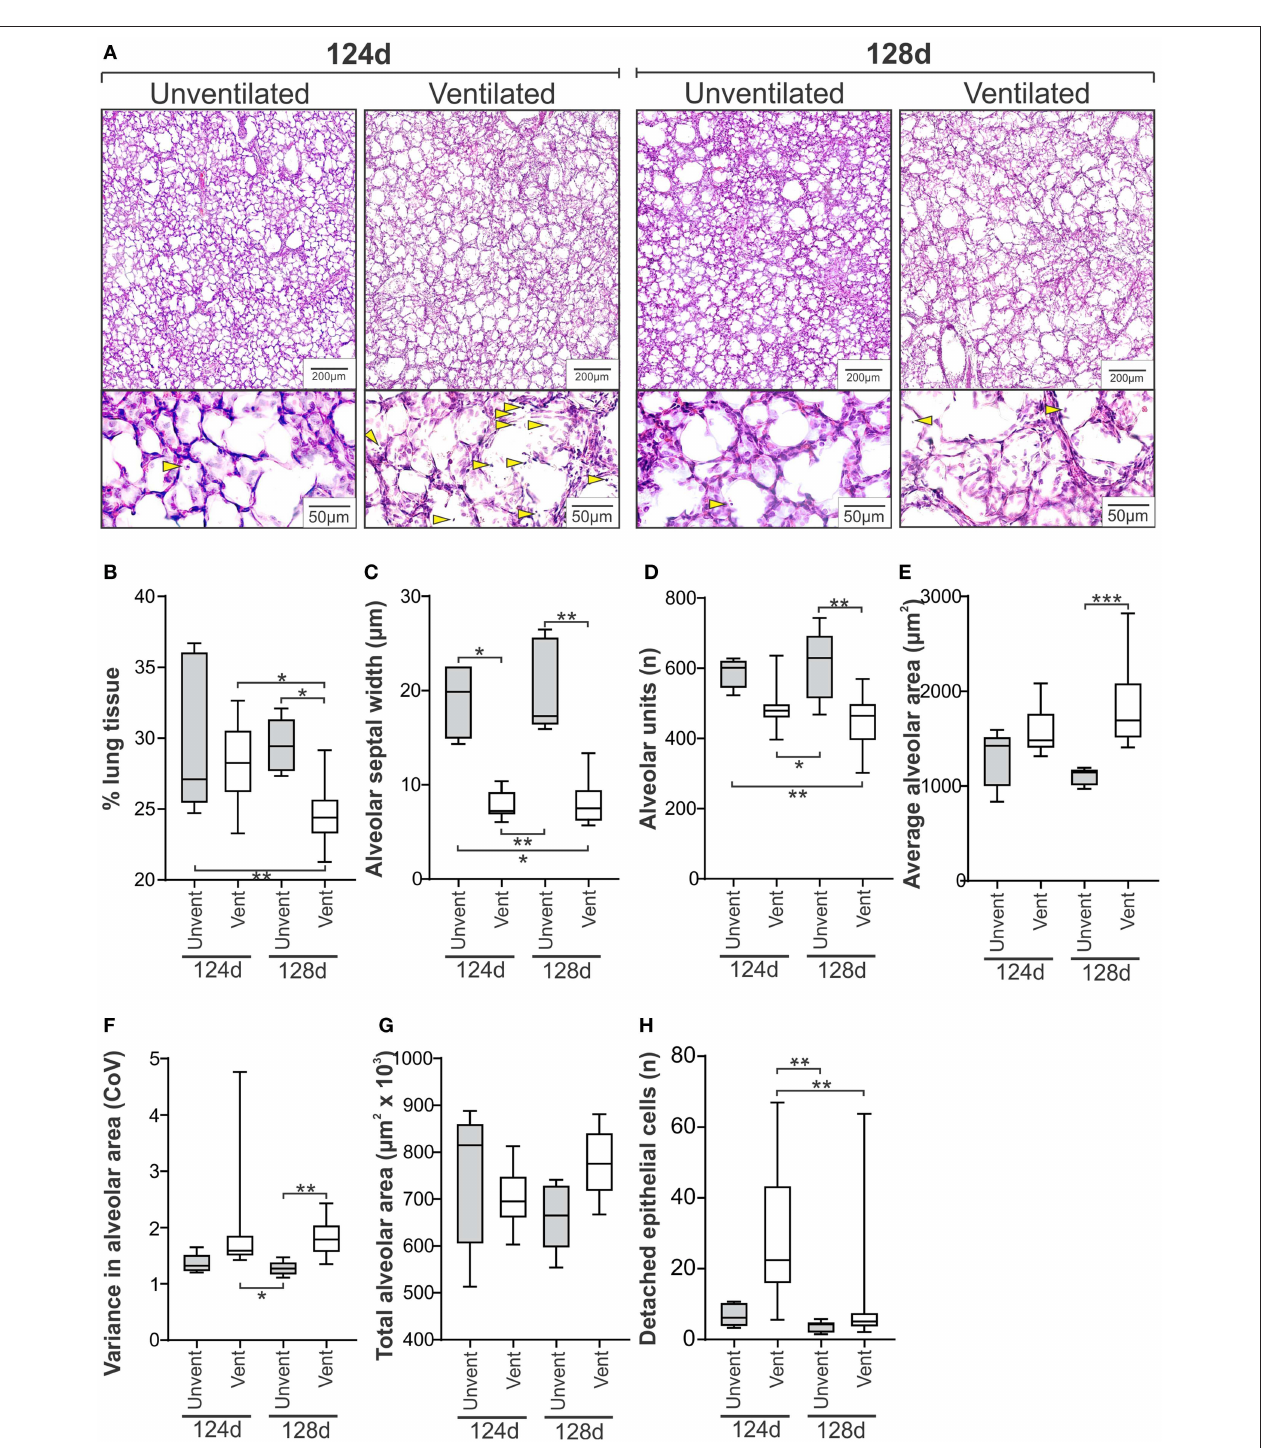
FIGURE 2 | Histological measures of lung injury in the ventilated and unventilated lung ( Study 1 ). (A) Representative H&E stained micrographs of lung tissue from unventilated and ventilated lambs at 124d and 128d gestation at low and high magnification exemplifying lung morphology and presence of detached epithelial cells (lower panel, blunted yellow arrows). Quantitative histological assessments shown for % lung tissue (B) , alveolar septal width (C) , number of alveoli per image (D) , average alveolar area (E) , variance in alveolar area (F) , total alveolar area per image (G) , and number of detached epithelial cells per image (H) . The boxes encompass the 25th to 75th percentiles and line within the box the median. Whisker caps denote the maximum and minimum values. * P < 0.05, ** P < 0.01, *** P < 0.001 as determined by parametric or non-parametric ANOVA as appropriate [one-way ANOVA; (B,D,G) or Kruskall-Wallis ANOVA; (C,E,F,H) ] with post hoc testing to identify intergroup differences (Tukey’s post hoc test or Dunn’s multiple comparison test,